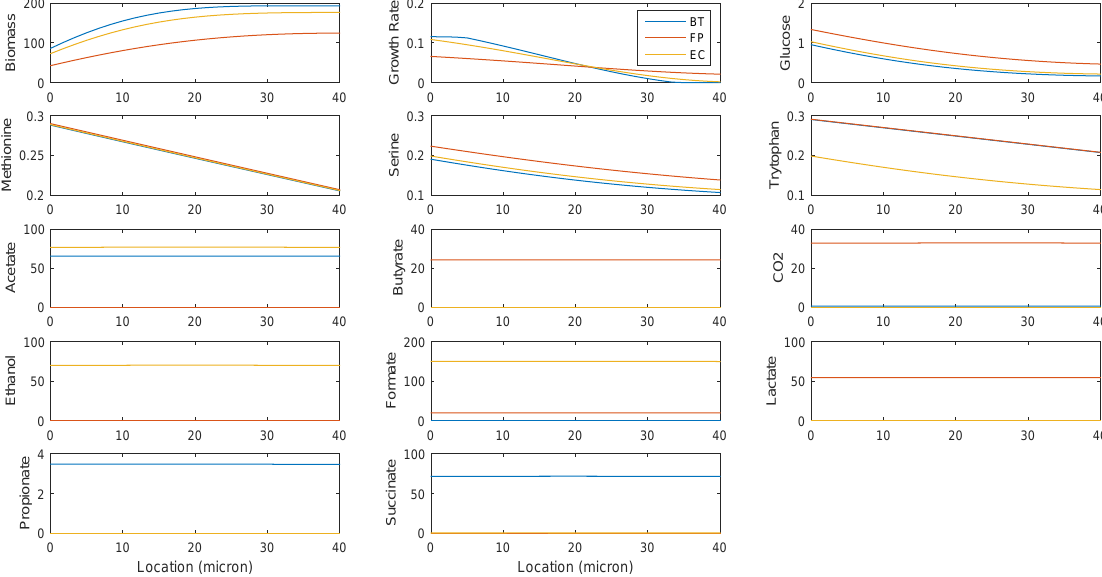
Figure 2. Steady-state spatial profiles predicted by single species biofilm models. Units are g/L for biomass, h − 1 for growth rate and mmol/L for the other variables. Species: BT denotes B. thetaiotaomicron , FP denotes F. prausnitzii and EC denotes E. coli